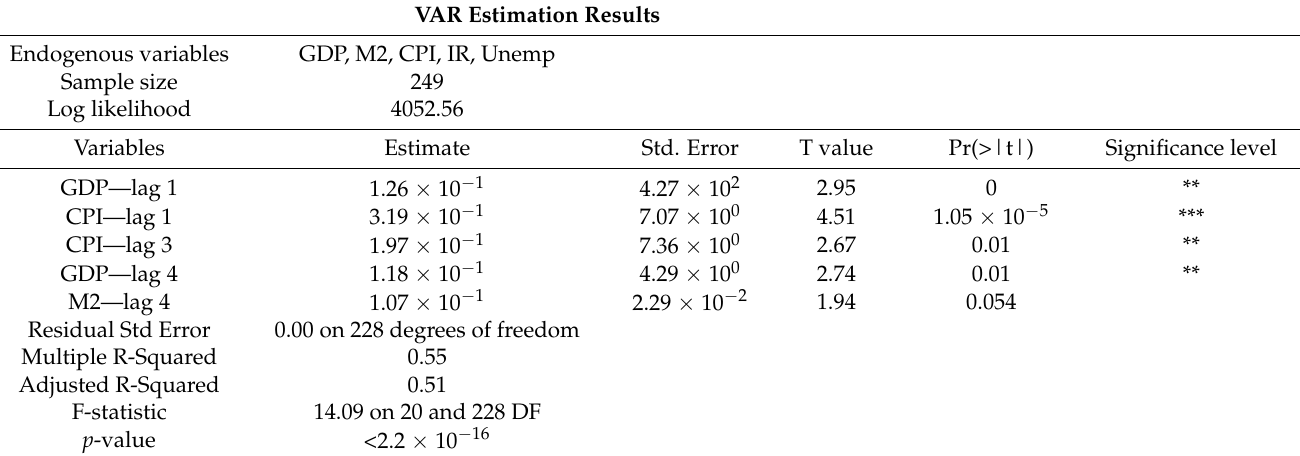
Table 7. VAR estimation of Consumer Price Index (CPI).